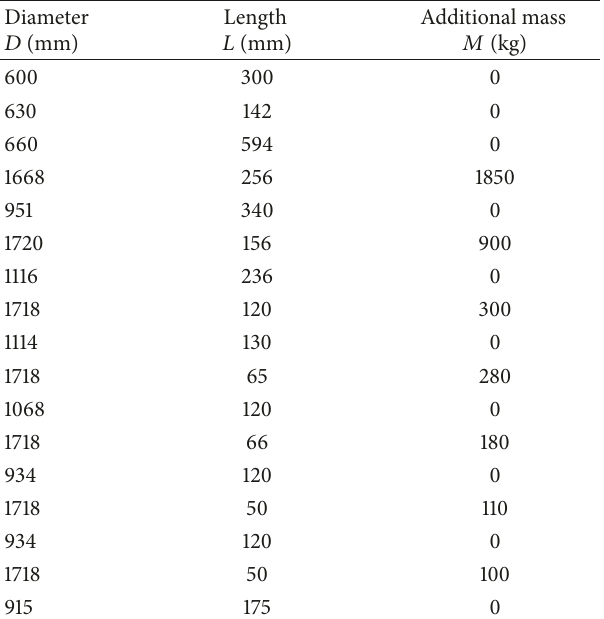
Table 5: Comparison of system